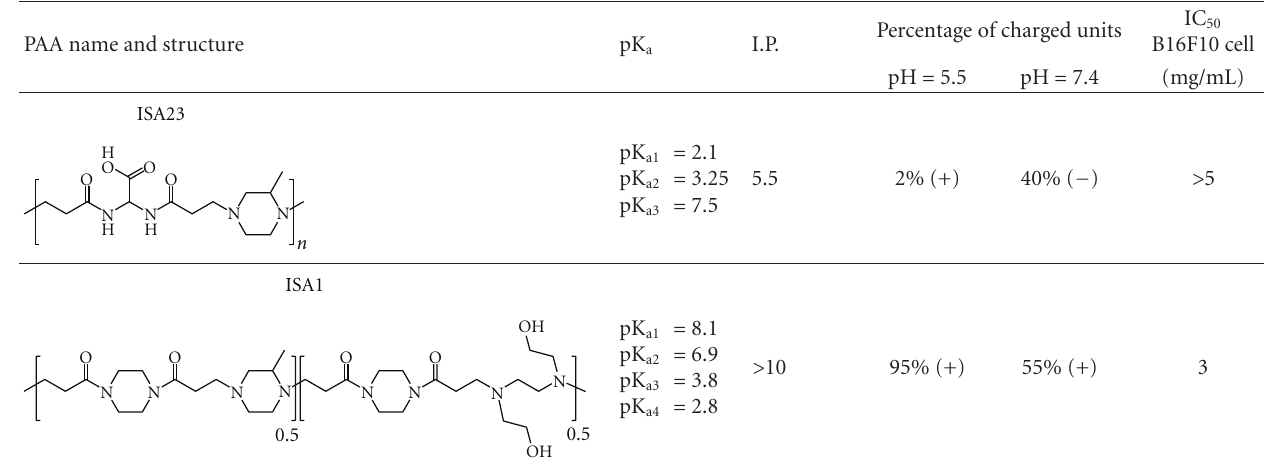
Table 1: Acid-base properties of the same PAA polymers. PAA name and